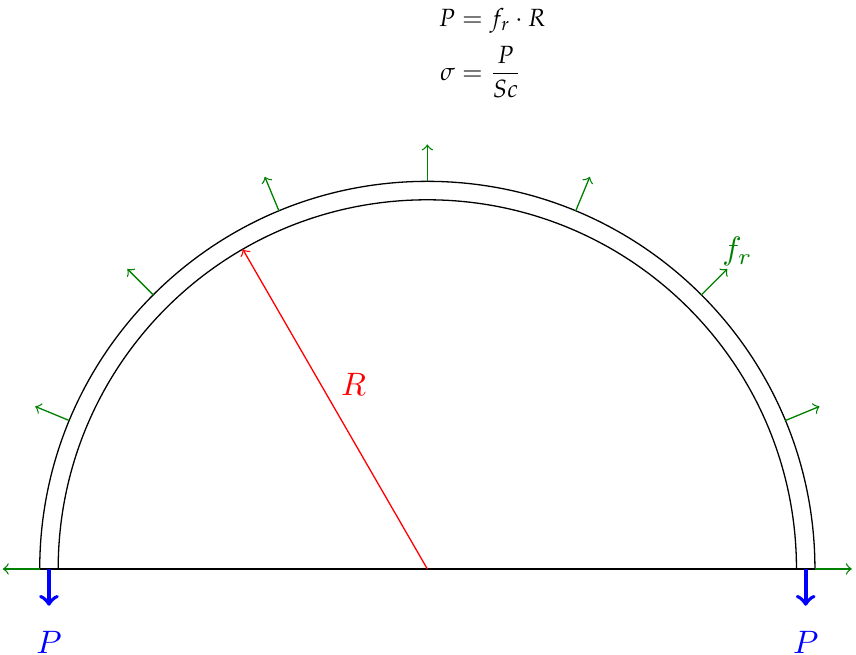
Figure 6. Ring subject to the action of a radial force f and a force P perpendicular to its section.